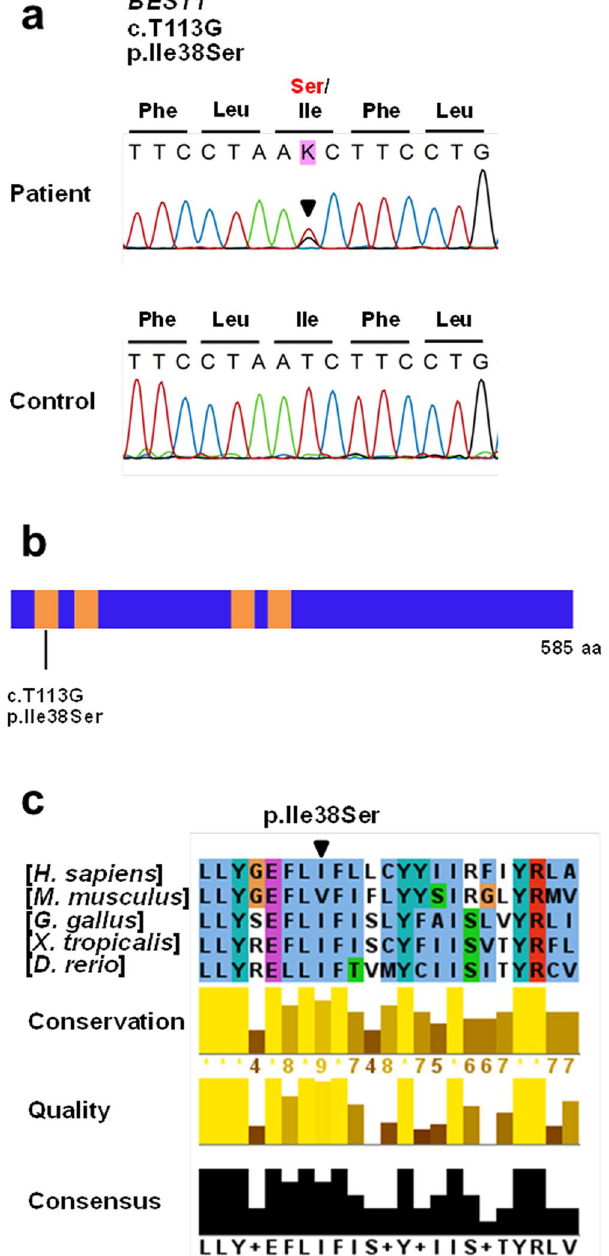
Figure 2. Genetic analysis of the patient identified a novel BEST1 mutation, p.Ile38Ser. (a) Sequencing traces of the mutation and wild type control. Altered nucleotide and amino-acid changes are indicated above the sequence traces. (b) Domain structure of BEST1. The transmembrane (TM) domains are depicted by orange colored bars. The BEST1 mutation is located in the TM1 domain. (c) Partial protein alignment of BEST1 TM1 domain showed evolutionary conservation of the identified missense